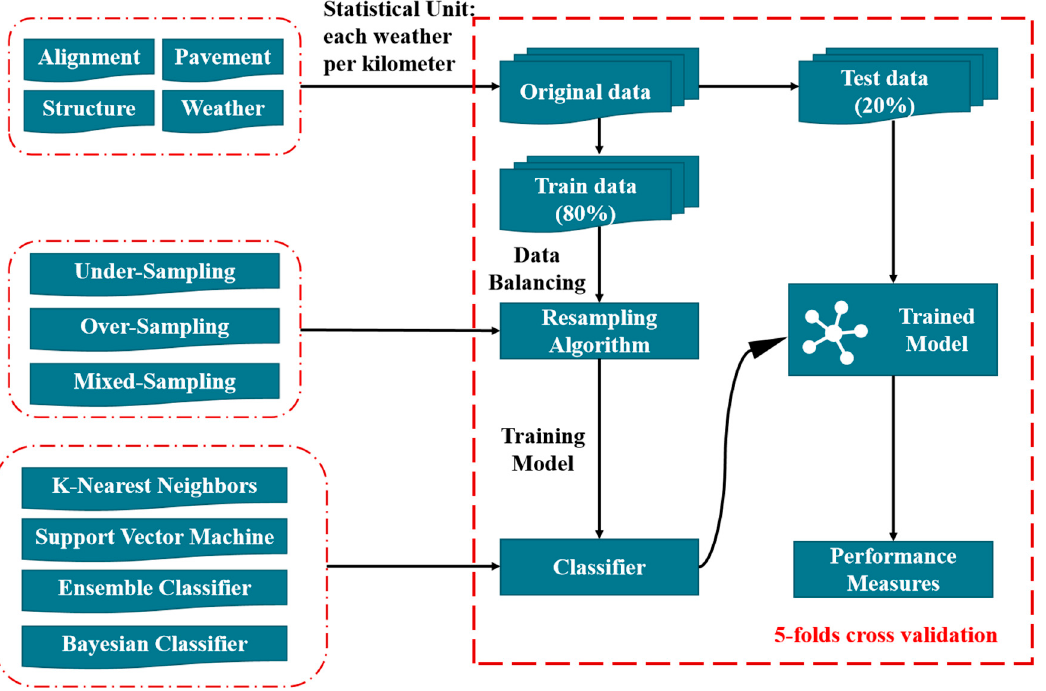
Figure 1. Section division by the homogeneous method; stratified k-fold cross-validation was used to compare the developed models, which was repeated 5 times.